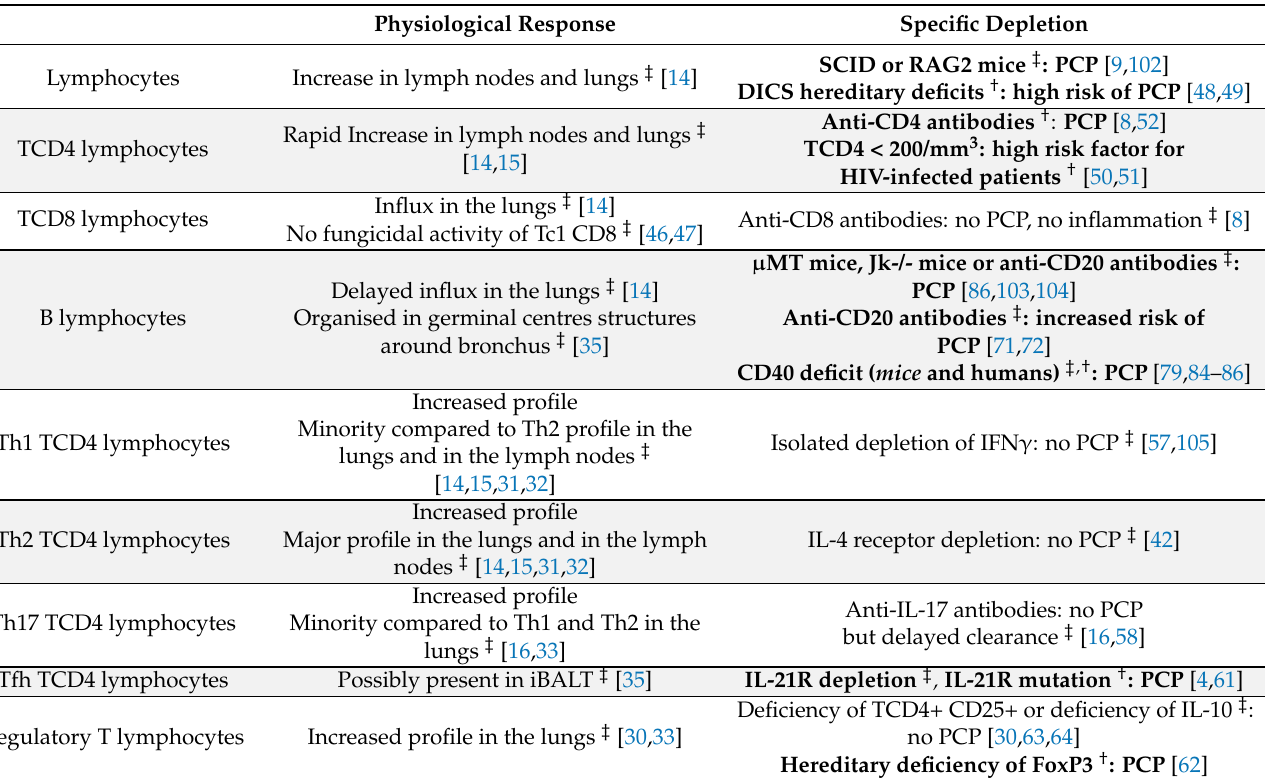
Table 1. Fluctuation of immune cells during Pneumocystis infection under physiological conditions and impact of their